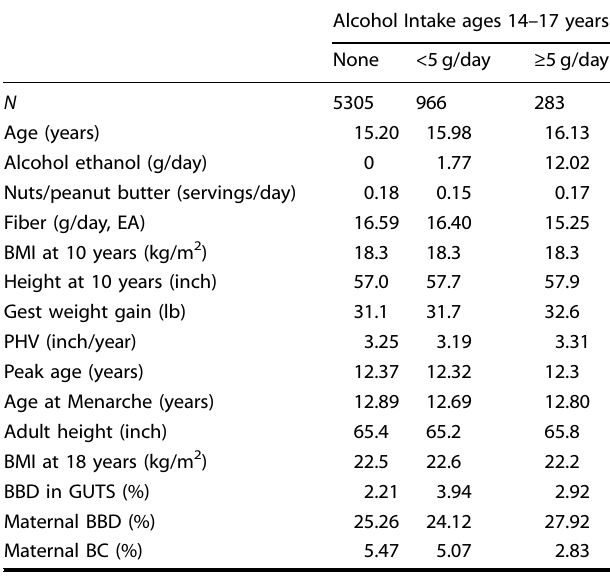
Table 1. Participant exposures and characteristics within category of alcohol intake from ages 14 through 17 years a .